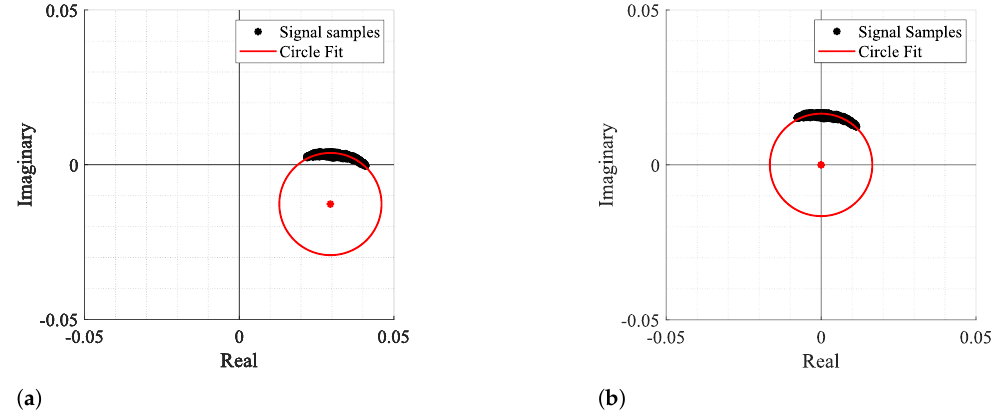
Figure 3. Example of how fitting methods can provide an accurate center estimation: ( a ) Circle fitting result, ( b ) Arc disposition after removing the CDC offsets.